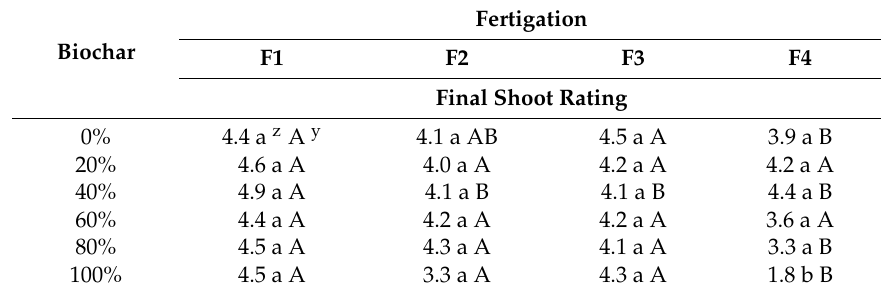
Table 7. Shoot final visual rating of ‘Prestige Red’ poinsettia 15 weeks after transplanting in root substrate amended with six different percentages of biochar and fertilized with four fertigation